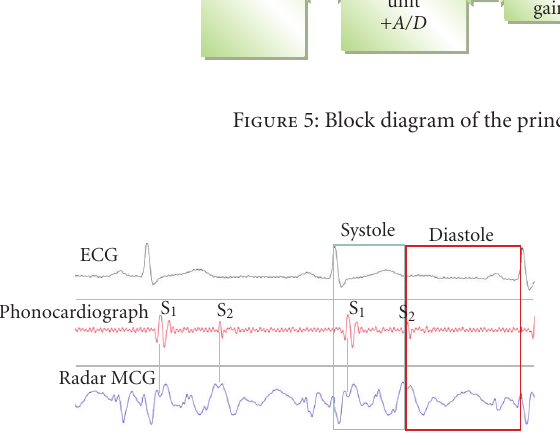
Figure 6: Two cycles of synchronous radar MCG, phonocardio- graph, and ECG signal showing the correlation of cardiac cycle events to radar MCG signal. Systolic and diastolic complexes can be identified in the radar MCG signal corresponding to S1 and S2 of heart’s sounds. Table 1: The heart rate and respiration rate measurements using the MCG device for eight subjects. The numbers represent the percentage of correctly detected heart beats or breathing cycles to the total number of heart beats or breathing